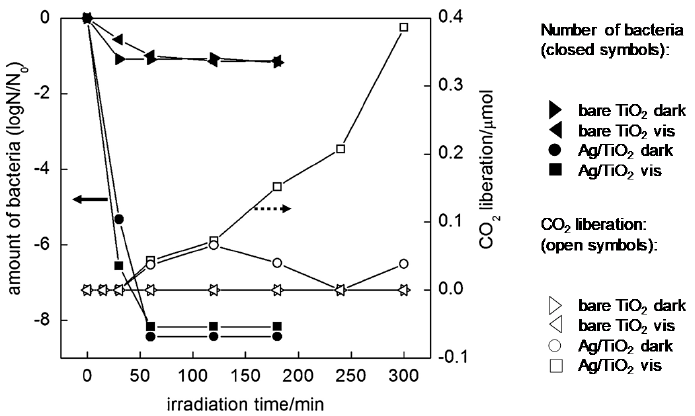
Figure 3. SEM images of the decomposition of E. coli under vis ( λ > 420 nm) irradiation of Ag/TiO 2 photocatalyst: ( a ) healthy bacteria cells, ( b ) bacteria covered with titania before photocatalytic reaction, ( c , f ) destroyed bacteria cells after: ( c ) 1 h, ( d , e ) 3 h and ( f ) 24 h of irradiation; adapted with permission from [115]. Copyright 2018, Creative Commons Attribution.